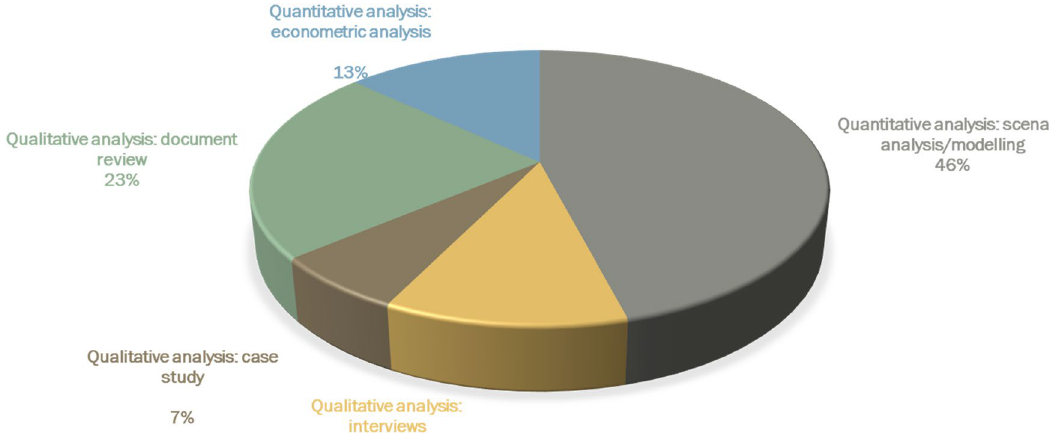
Fig. 6 Methods used in the publications reviewed. Source: